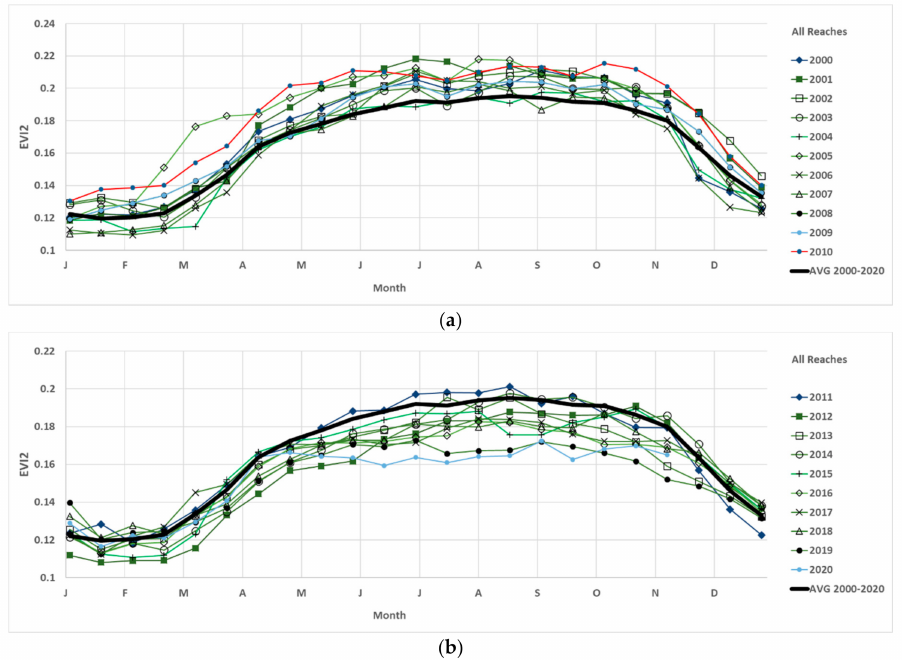
Figure 5. EVI2 time-series information for All reaches for the full year with months on the x -axis (J-D), for individual years 2000–2010 ( a ) and 2011–2020 ( b ), and for each decade. The bold line shows the full 21-year period,